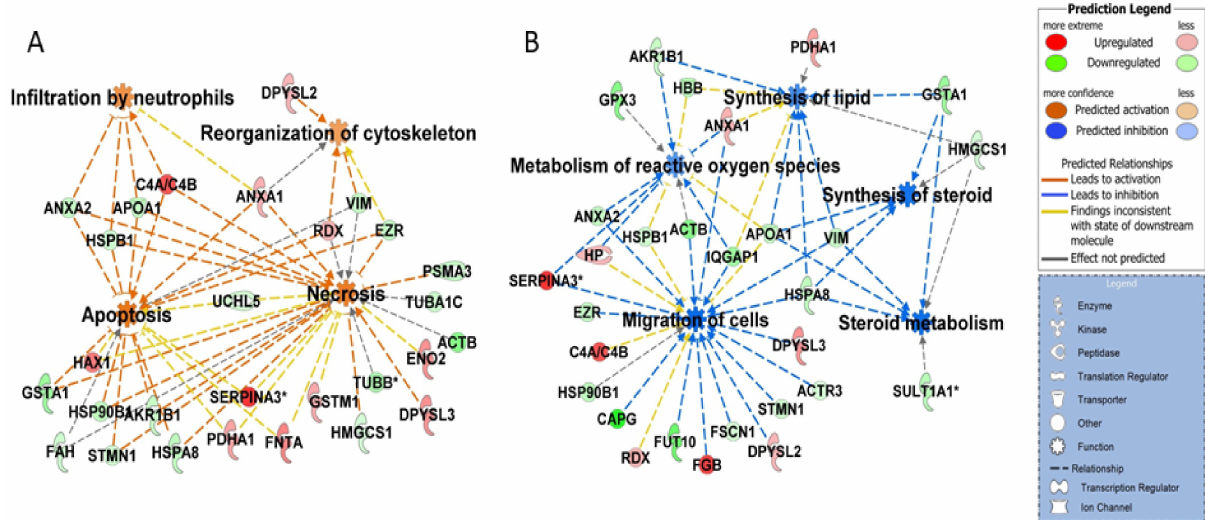
Figure 3. IPA disease and function analysis of differentially abundant proteins. Top functions ranked in accordance to z-score ( − 2.0 ≥ z-score ≥ 2.0) with corpus luteum regression on Day 15 as compared to Day 12 of the estrous cycle showed ( A ) enrichment of functions: apoptosis, necrosis, reorganization of cytoskeleton, and infiltration by neutrophils and ( B ) inhibition of functions: synthesis of lipids, synthesis of steroid, steroid metabolism, metabolism of reactive oxygen species, and migration of cells. Red and green colors depict an increase or decrease, respectively, in abundance of the